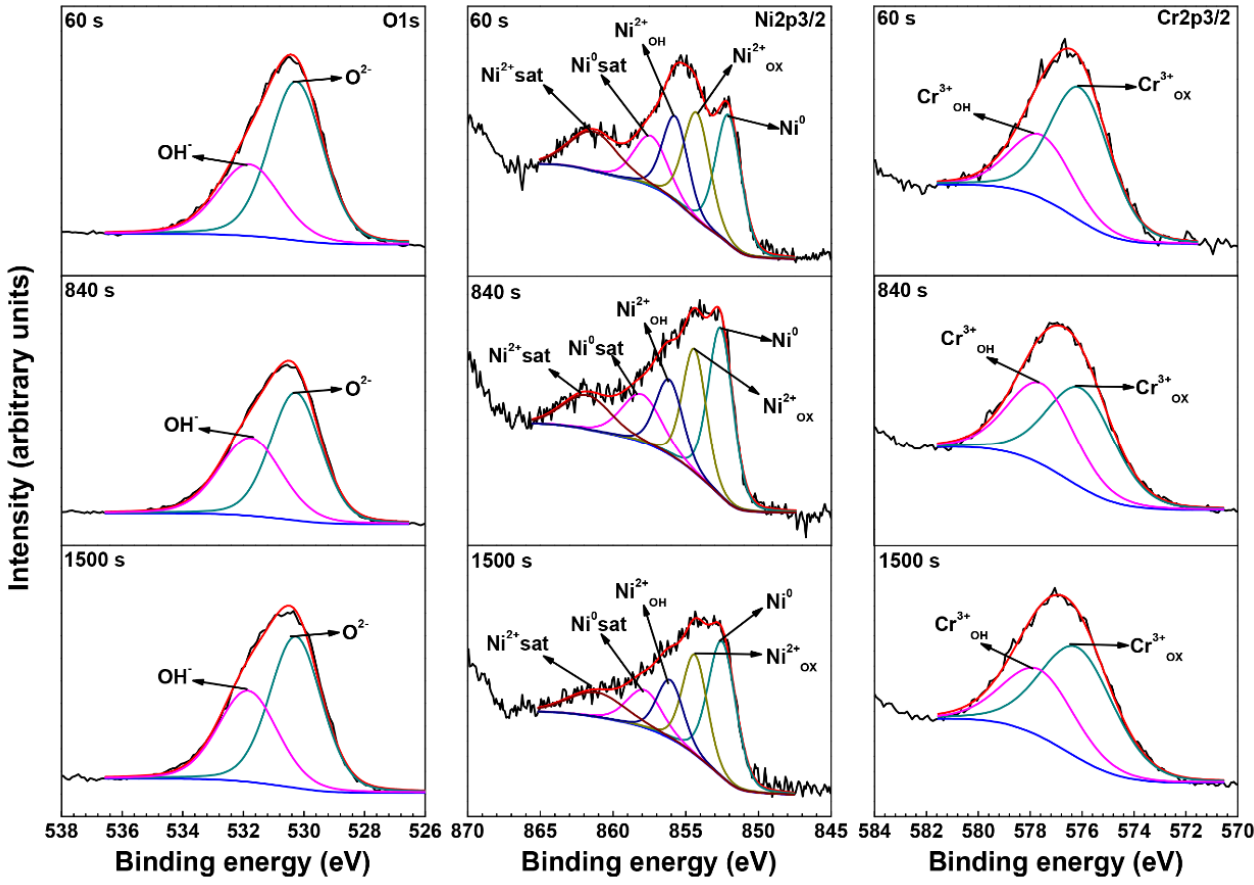
Figure 7. The O 1s, Ni 2p3/2 and Cr 2p3/2 core lever spectra on the crevice mouth of the crevice sample exposed to 290 °C NaCl solution.